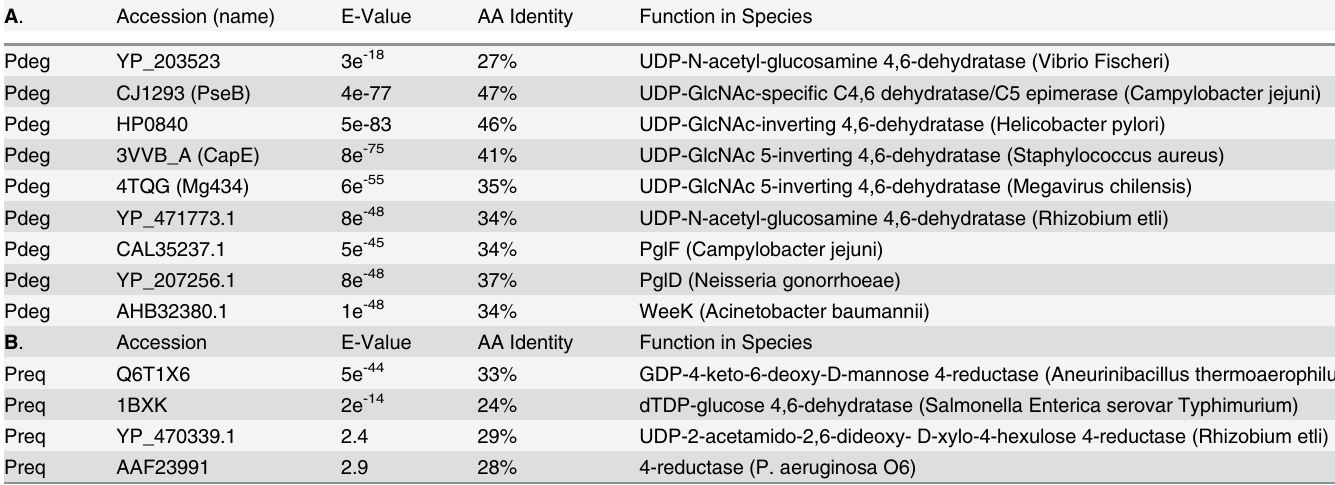
Table 1. Comparative analysis of Bacillus cereus ATCC 14579 proteins Pdeg (Bc3750) and Preq (Bc3749) with known genes encoding UDP-sugar 4,6-dehydratase (A) and 4-reductase (B) from bacterial sp. A